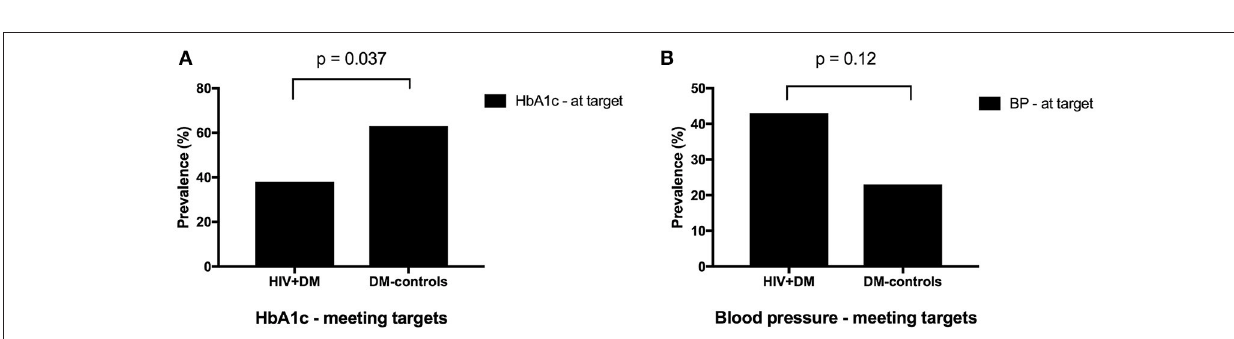
FIGURE 2 | Proportion of clinic attendees meeting individualized ADA benchmarks for HbA1c (A) and blood pressure (B)